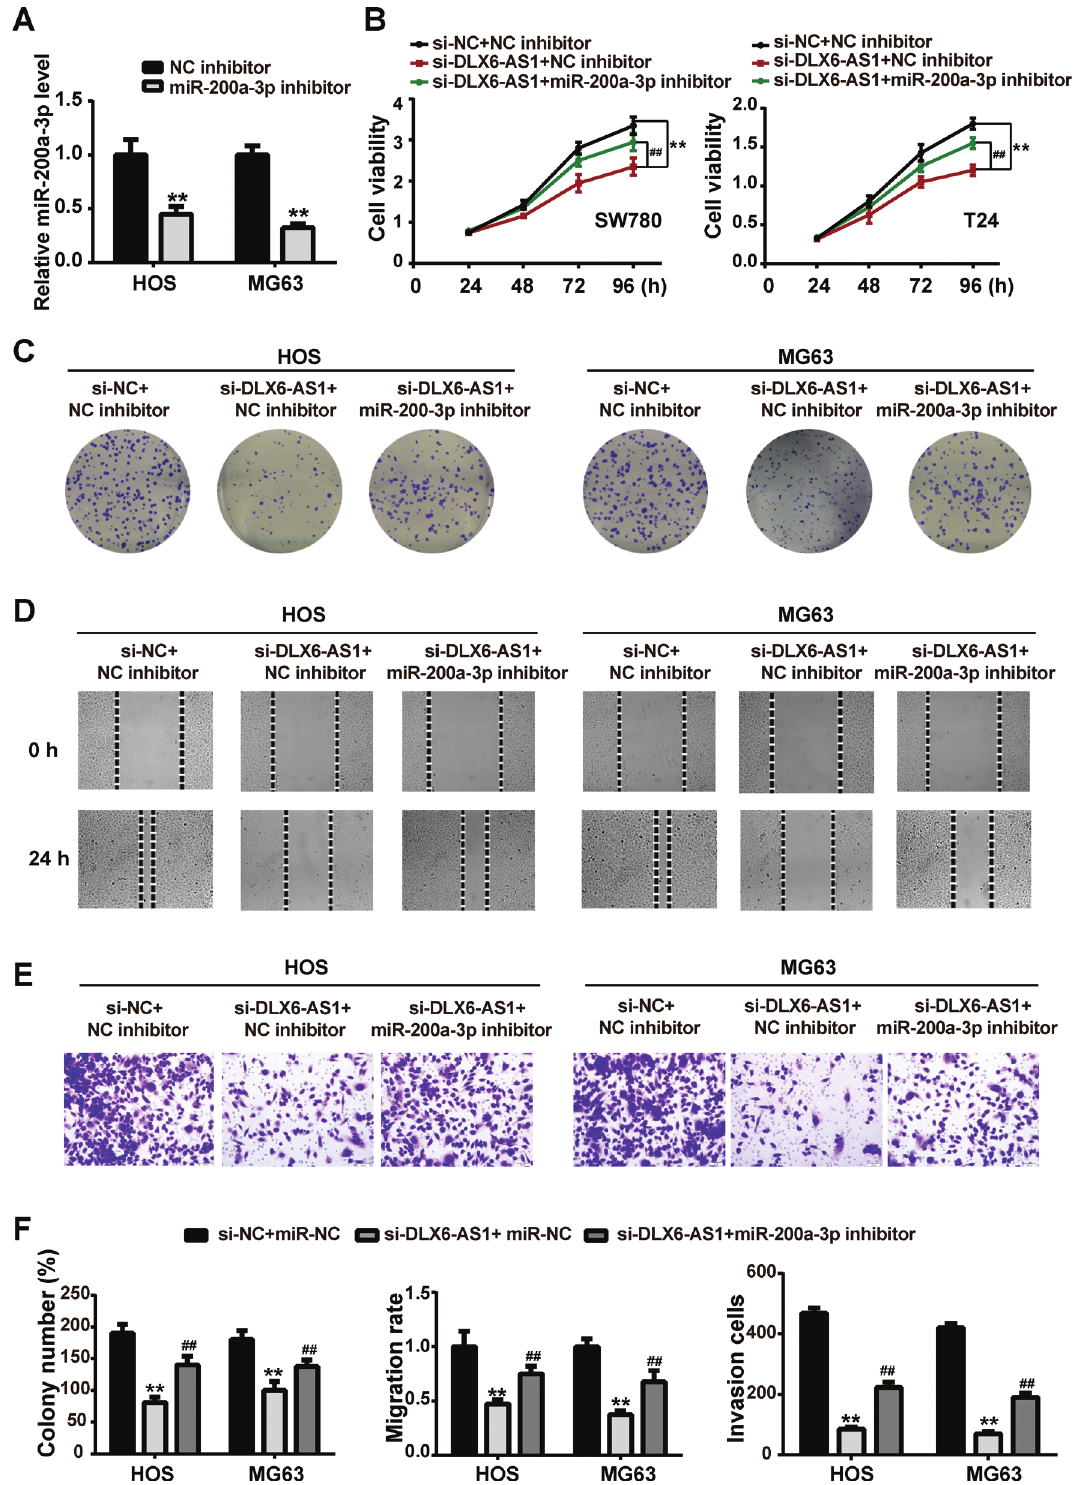
Fig. 4. DLX6-AS1 regulated OS progression through miR-200a-3p. (a) Relative expression levels of miR-200a-3p in OS cells after miR-200a-3p inhibitor transfection. (b, c) Colony formation assay and CCK-8 assay were performed to estimate cell pro- liferation with si-DLX6A transfection under miR-200a-3p inhibitor or NC inhibitor. (d, e) Cell migration and invasion were investigated through the wound healing assay and transwell assay with miR-200a-3p inhibitor or NC inhibitor. (f) Quantitative analysis was presented as bar graphs. NC, negative control. ** P < 0.01, versus NC inhibitor or si-NC+NC inhibitor; ##<0.01, versus si-DLX6-AS1+NC